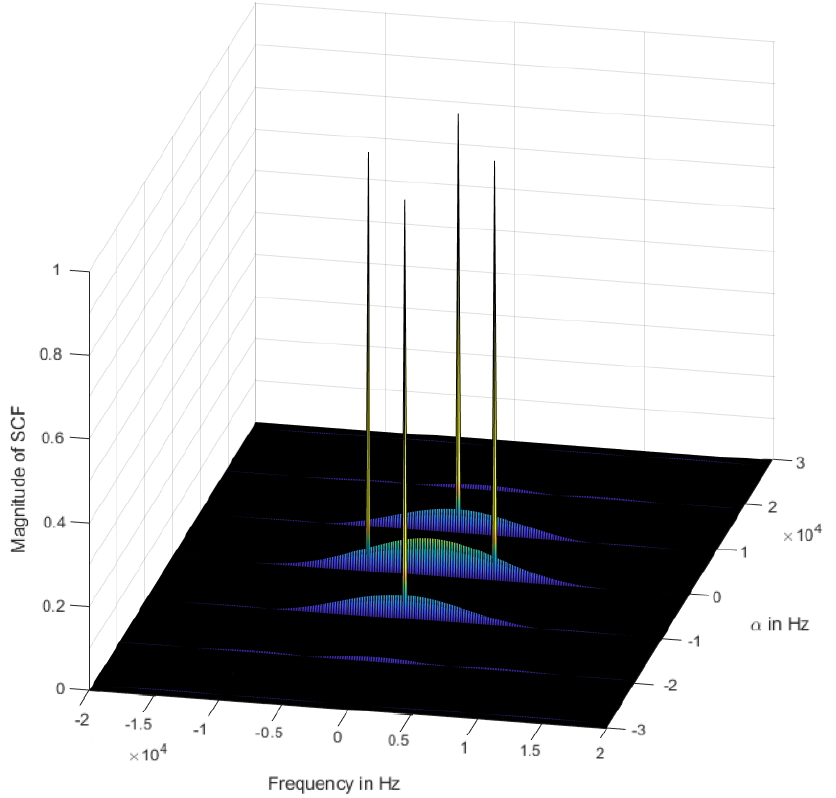
Figure 4. Spectral correlation function (SCF) of a Gaussian frequency-shift keying (GFSK) modulated signal with a symbol rate of f s = 9600 symbols and a center frequency of f 0 = 0 second